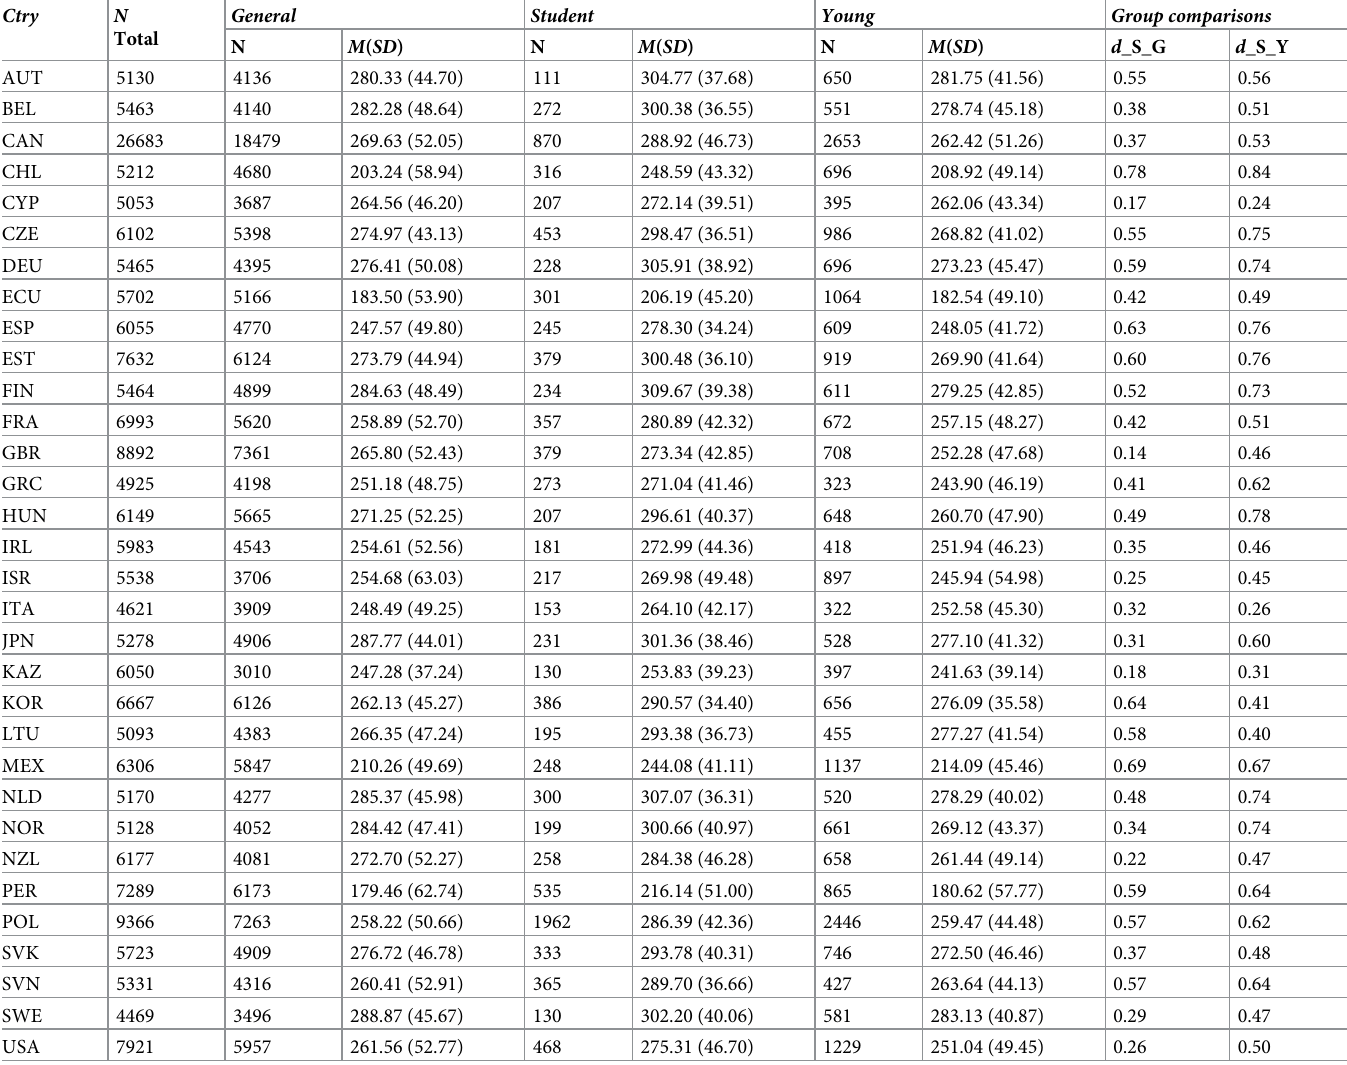
Table 2. Descriptive statistics of numeracy for the General, Young, and Student national samples, and Cohen’s d estimates of differences between Student and Gen- eral samples, and Student and Young samples, presented by